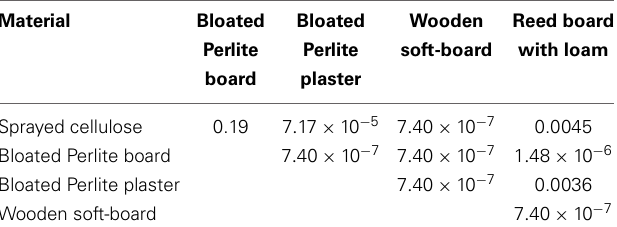
Table 3 | P -value returned by the Wilcoxon test for the pairwise comparison of fungal abundance for different